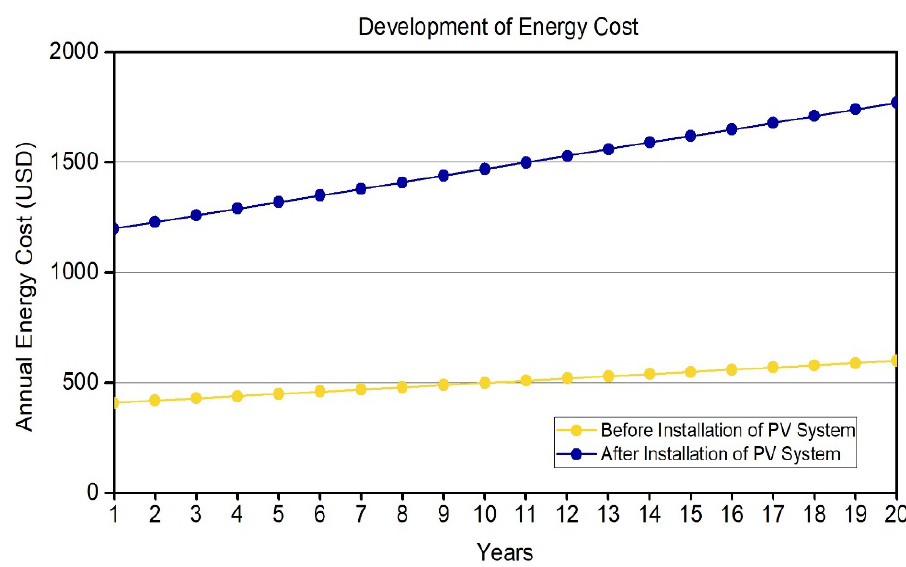
Figure 14. Financial analysis of solar PV—year-wise comparison.